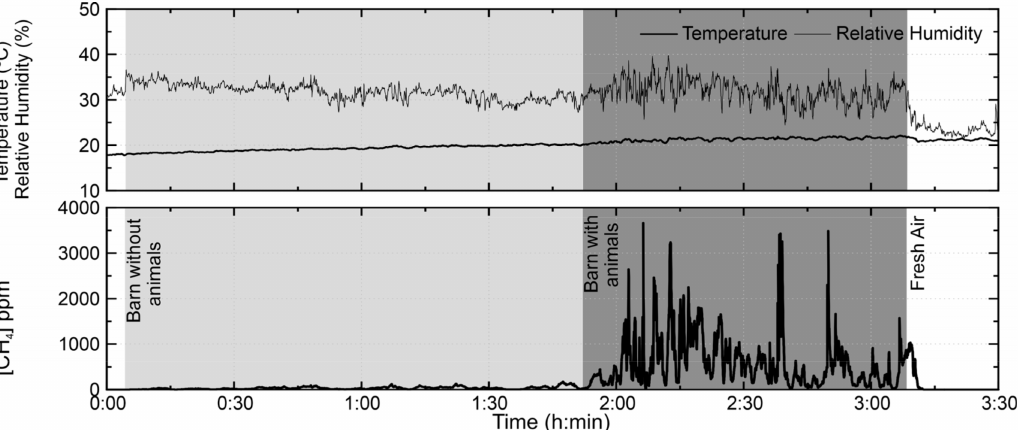
Figure 12. TGS2600 test on 15 May 2017 in the small ruminant barn of the Higher School of Agriculture of the Polytechnic Institute of Bragança. The test was performed covering three situations: the monitoring outside the barn (white area), inside the barn without animals (light grey area) and inside the barn with moving and restless animals (dark grey area).